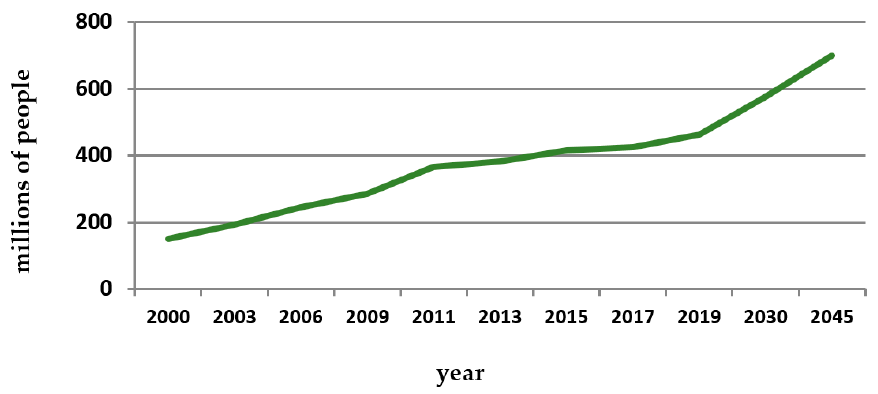
Figure 1. Estimated number of adults with diabetes (in millions) since 2000 to 2045. Source: IDF Diabetes Atlas editions [8].